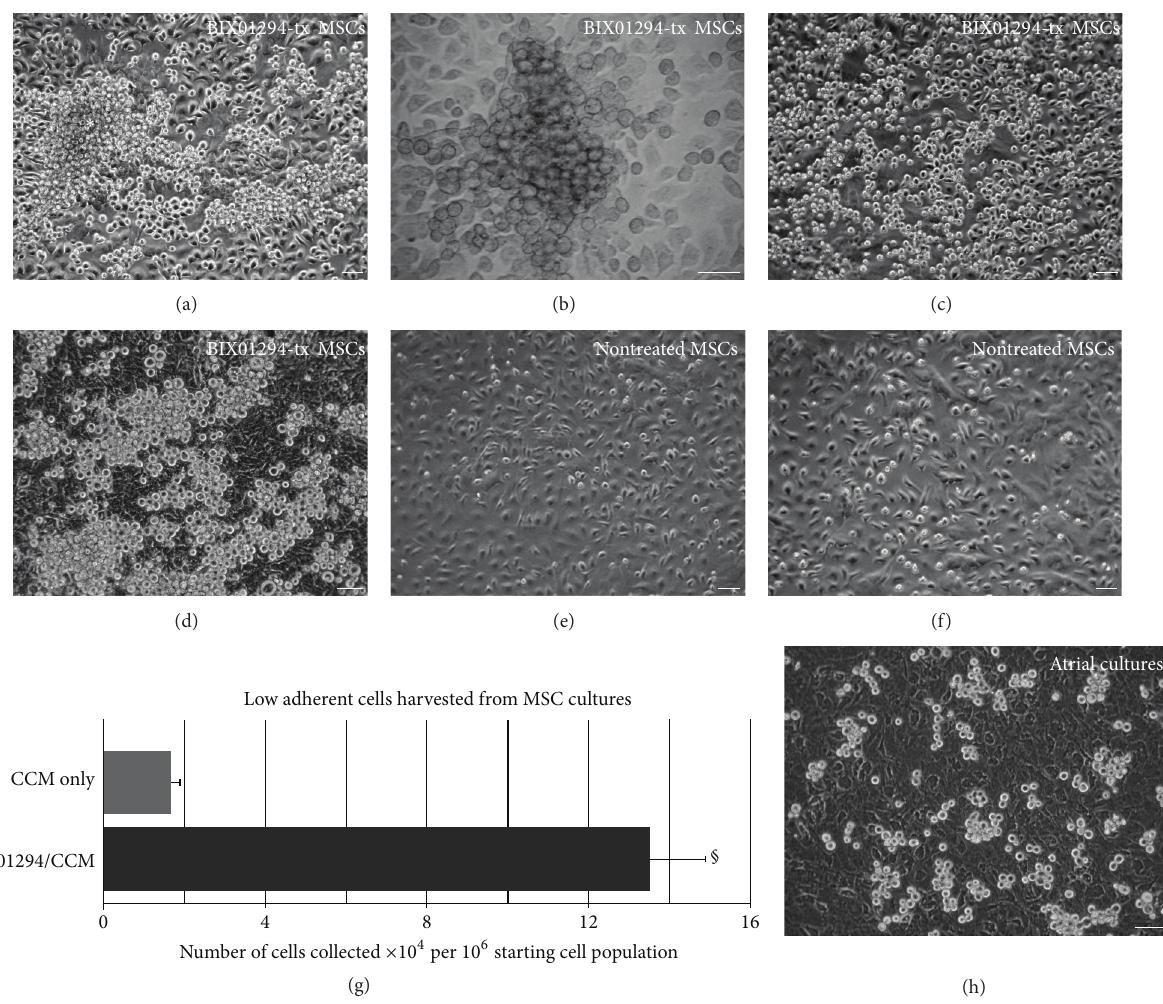
Figure 4: Acquisition of phase bright phenotype by BIX01294-treated MSCs. Phase-contrast images showing (a–d) BIX01294-treated MSCs that were subsequently incubated with CCM. By 48-hour exposure to CCM, BIX01294-treated MSCs (a) exhibited bursts of PBCs (asterisk), (b) which imaged in bright field at higher magnification appear as colony bursts. Subsequently, PBCs derived from BIX01294-treated MSCs spread throughout thecultures, as shown in the following (c) 4 days and (d) 2 weeks of CCMincubation. (e, f) Parallel MSC cultures incubated withCCMwithoutpriortreatmentwithBIX01294displayedfarfewerPBCs,asshownat2and4daysofincubation,respectively.(g)Tabulation of PBC yields from MSC cultures pretreated in presence or absence of BIX01294, as estimated by counting low adherent cells released by brief EDTA exposure. Note that preexposure to BIX01294 generated significantly greater numbers of PBCs from MSC cultures when exposed to CCM ( § 𝑝 < 0.001 ). The display of PBCs from the BIX01294 plus CCM-treated MSC cultures was similar to that (h) produced by cultures of atrial